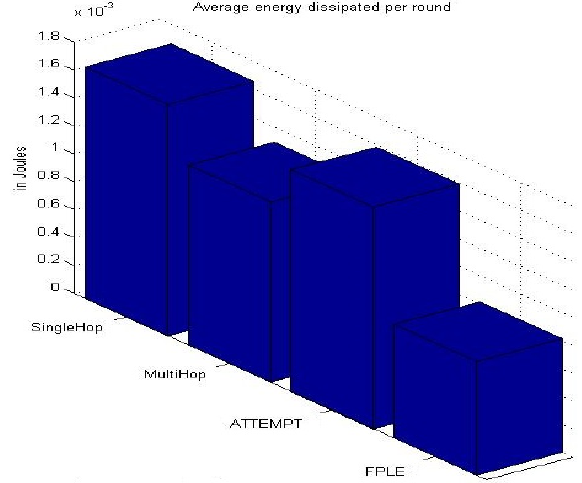
cycles of ECG data. The CMU marked with white flag activates the buzzer for fault data generation and low energy. Figure 8. Average energy consumed per round. Figure 8. Average energy consumed per round.